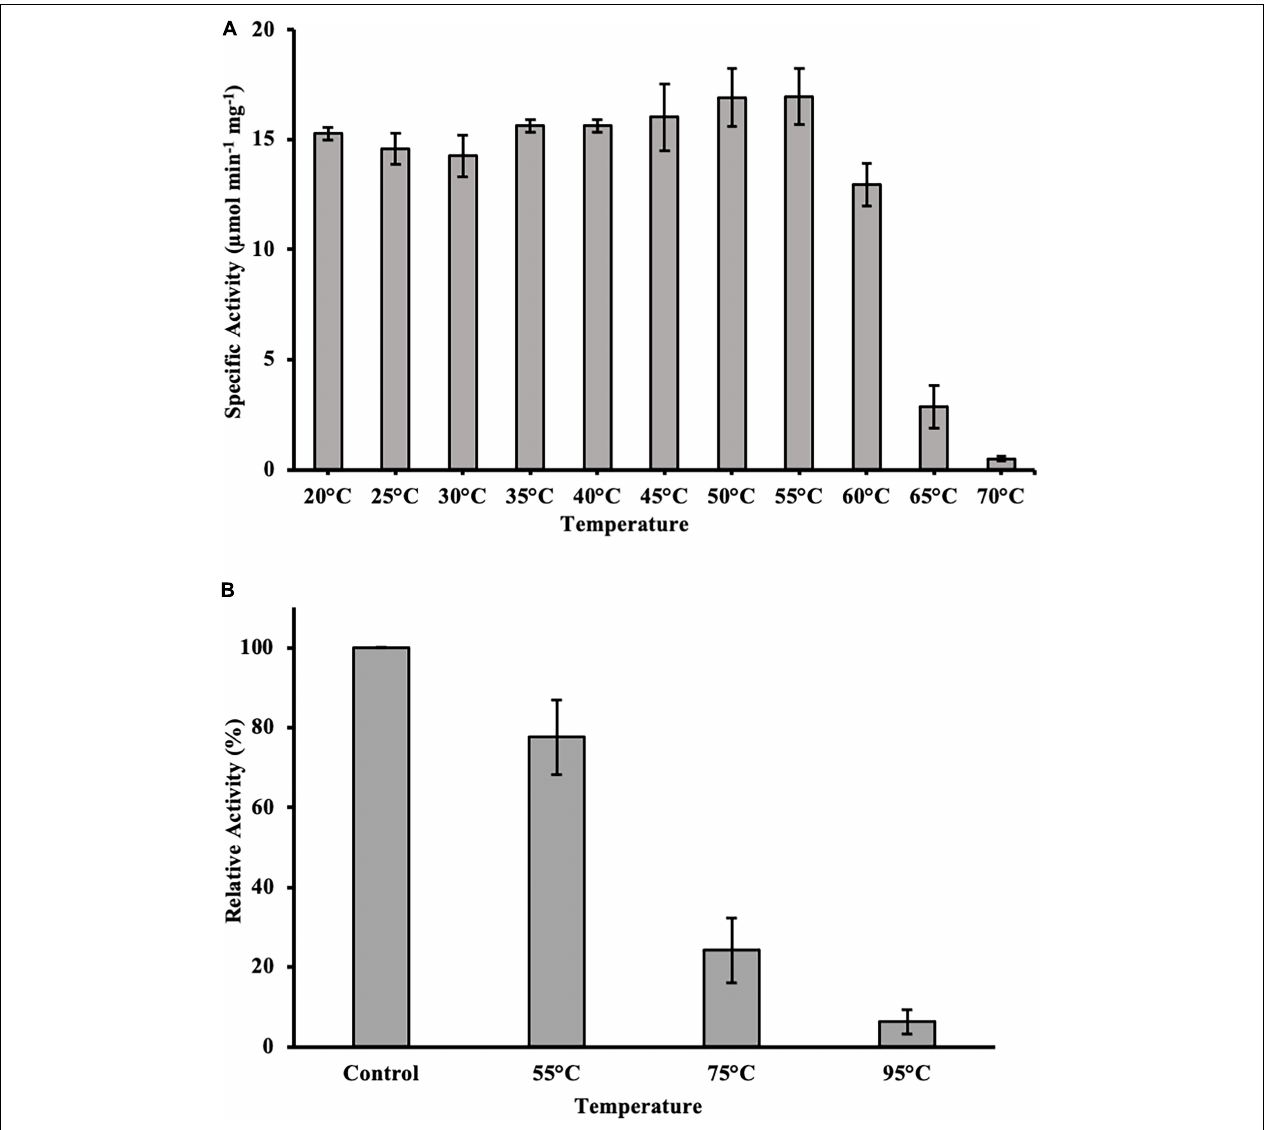
FIGURE 6 | (A) Heat stability of DS-007. After incubation of DS-007 for 1 h at 60 ◦ C, it still retains around 70% of its initial activity. Incubation at higher temperatures caused a more severe loss of activity. (B) Long term heat stability and refolding capacity. Incubation at 55 ◦ C for 18 h had a small impact on the activity of DS-007 in an in-gel assay when compared to room temperature (Control). The 75 ◦ C sample showed a decrease in activity (25% of the room temperature control). It seems that DS-007 recovers in the refolding process of the activity assay in-gel, thus showing lipolytic activity in the zymogram, even after incubation for 18 h at 75 ◦ C. Similarly, DS-007 incubated for 18 h at 95 ◦ C still shows detectable, albeit low lipolytic activity in-gel. The average and standard deviation of three independent experiments is shown.